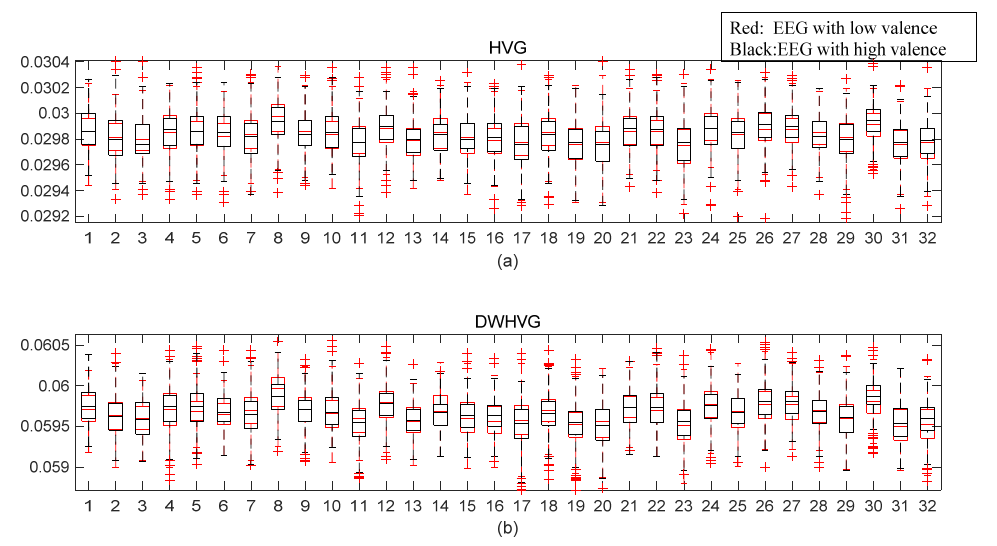
Figure 8. Box plots of the average weighted degree feature of 32 channels. ( a ) HVG; ( b ) DWHVG.